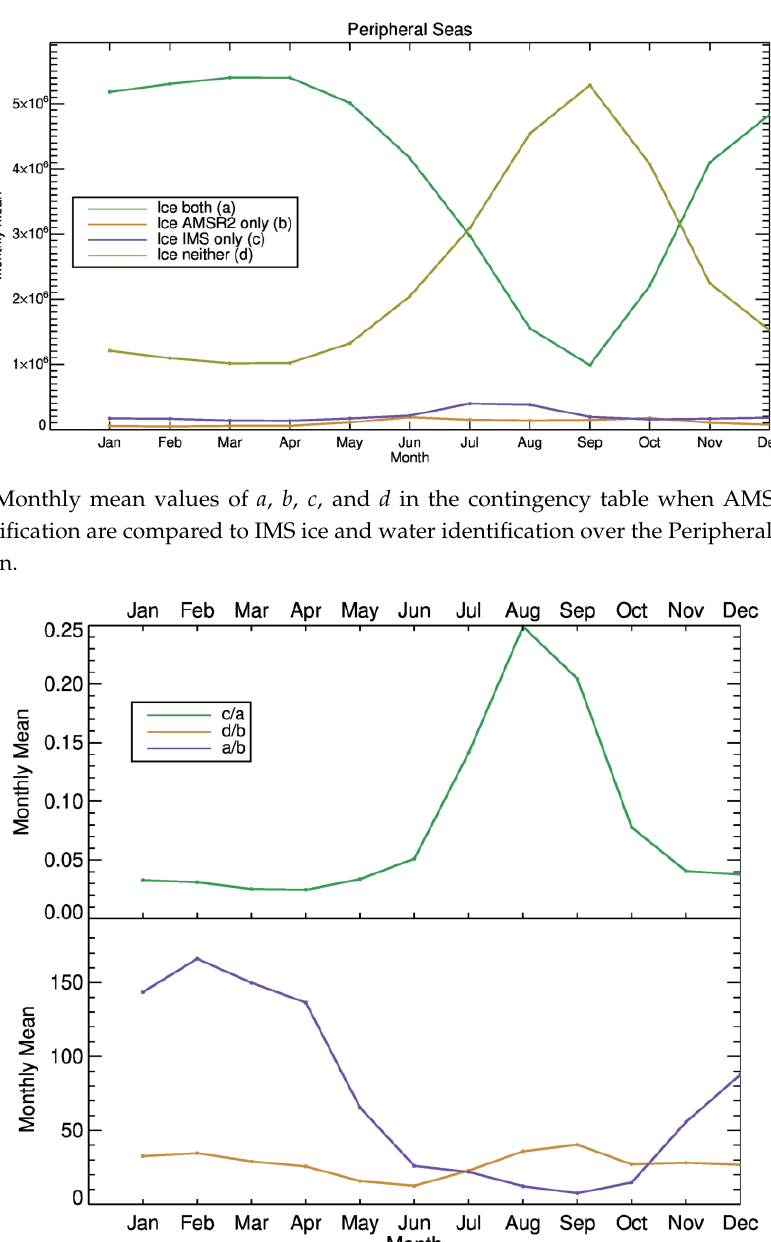
Figure 9. Monthly mean values of ratio c/a , d/b, and a/b when AMSR2 ice and water identification are compared to IMS ice and water identification over the Peripheral Seas of the Arctic Ocean.